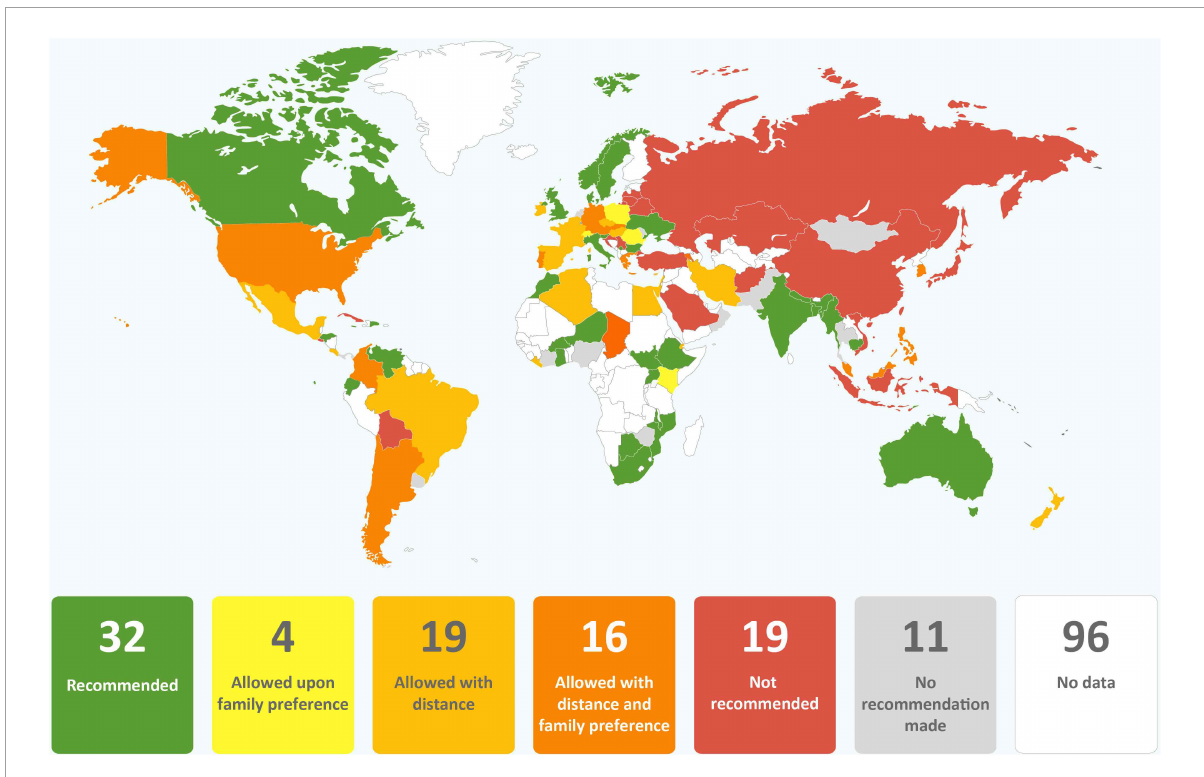
FIGURE5 Global distribution of recommendations for rooming in for infants of mothers with COVID-19 (data from 101 countries).